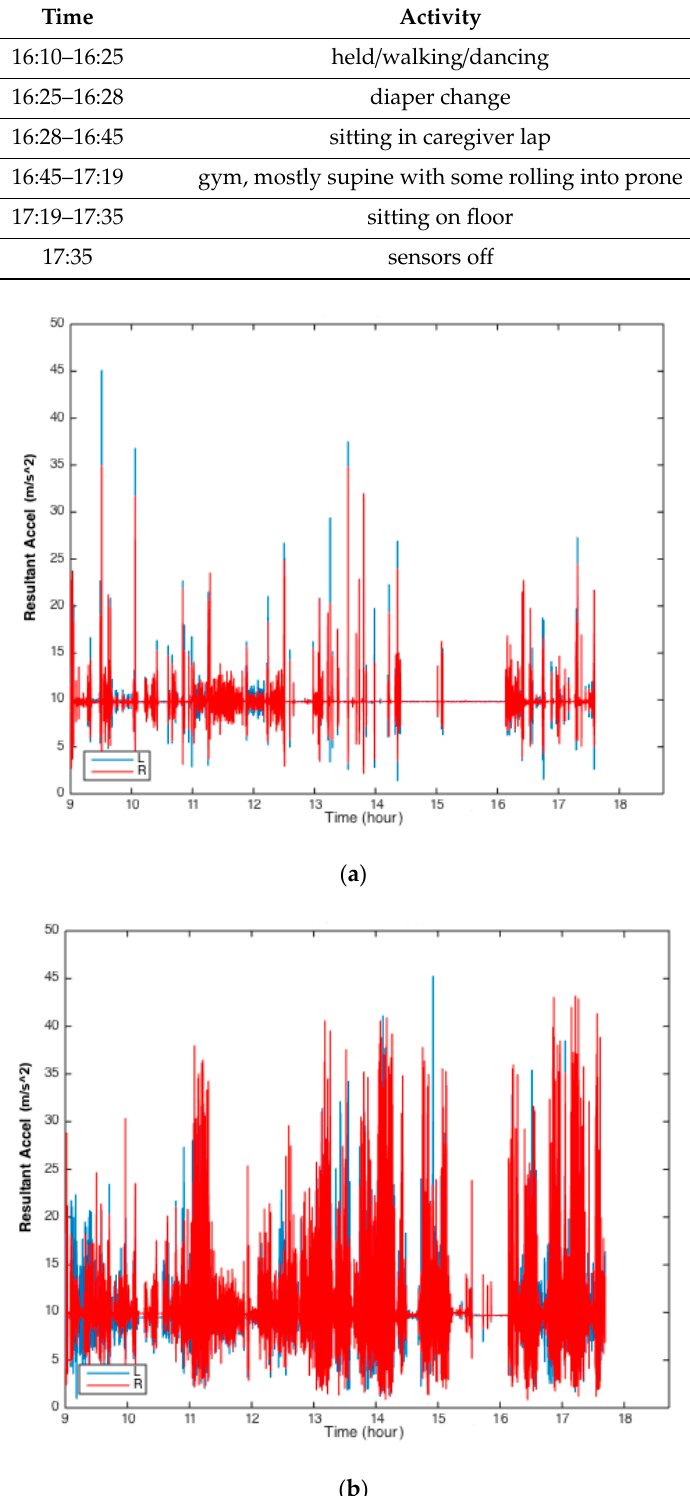
Figure 2. ( a ) Histogram of doll resultant raw acceleration signal from the left (L) and right (R) legs across a full day. ( b ) Histogram of infant resultant raw acceleration signal from the left (L) and right (R) legs across a full day.